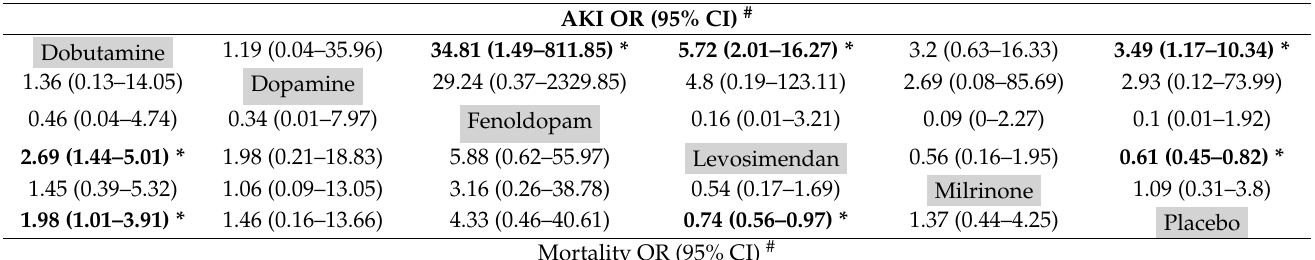
Table 1. Results from the multiple-treatment comparison analyses for mortality and acute kidney injury (AKI).